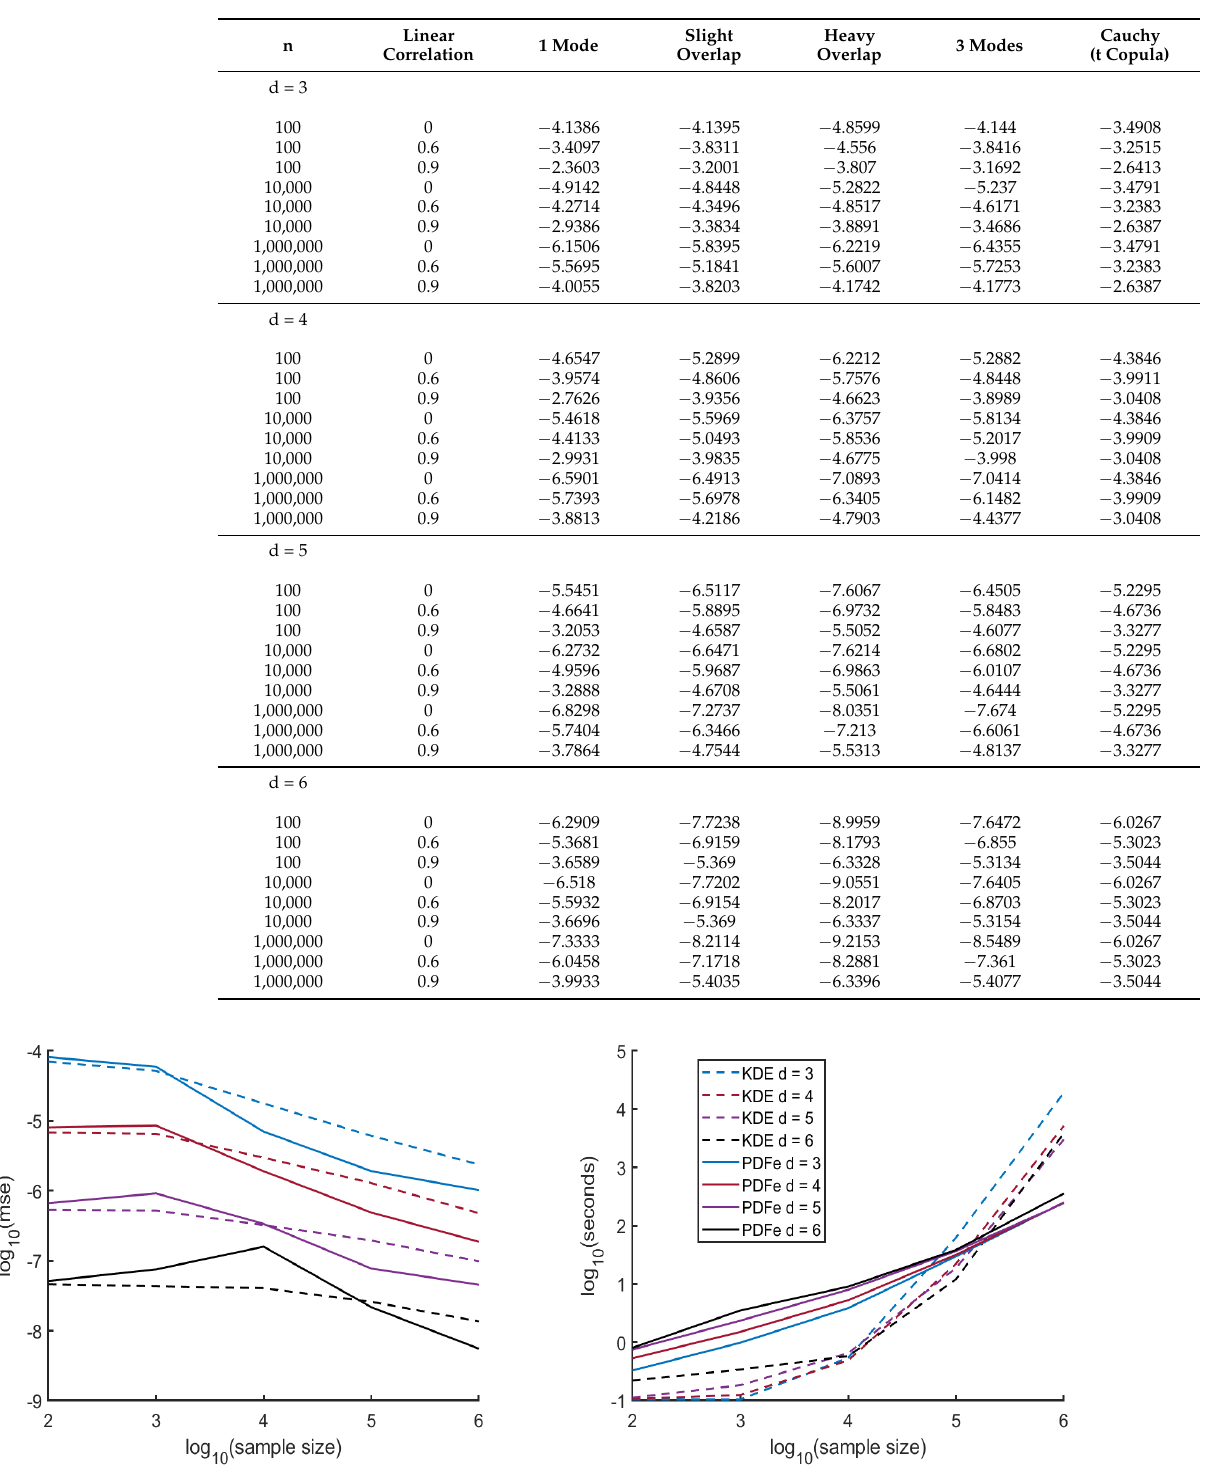
Figure 5. Performance benchmarks: mean squared error ( left ) and computation time ( right ) for synthetic data generated using the t-copula ( ν = 1) with Cauchy distribution and GMM for different correlations. The legend on the right panel applies to the left panel as